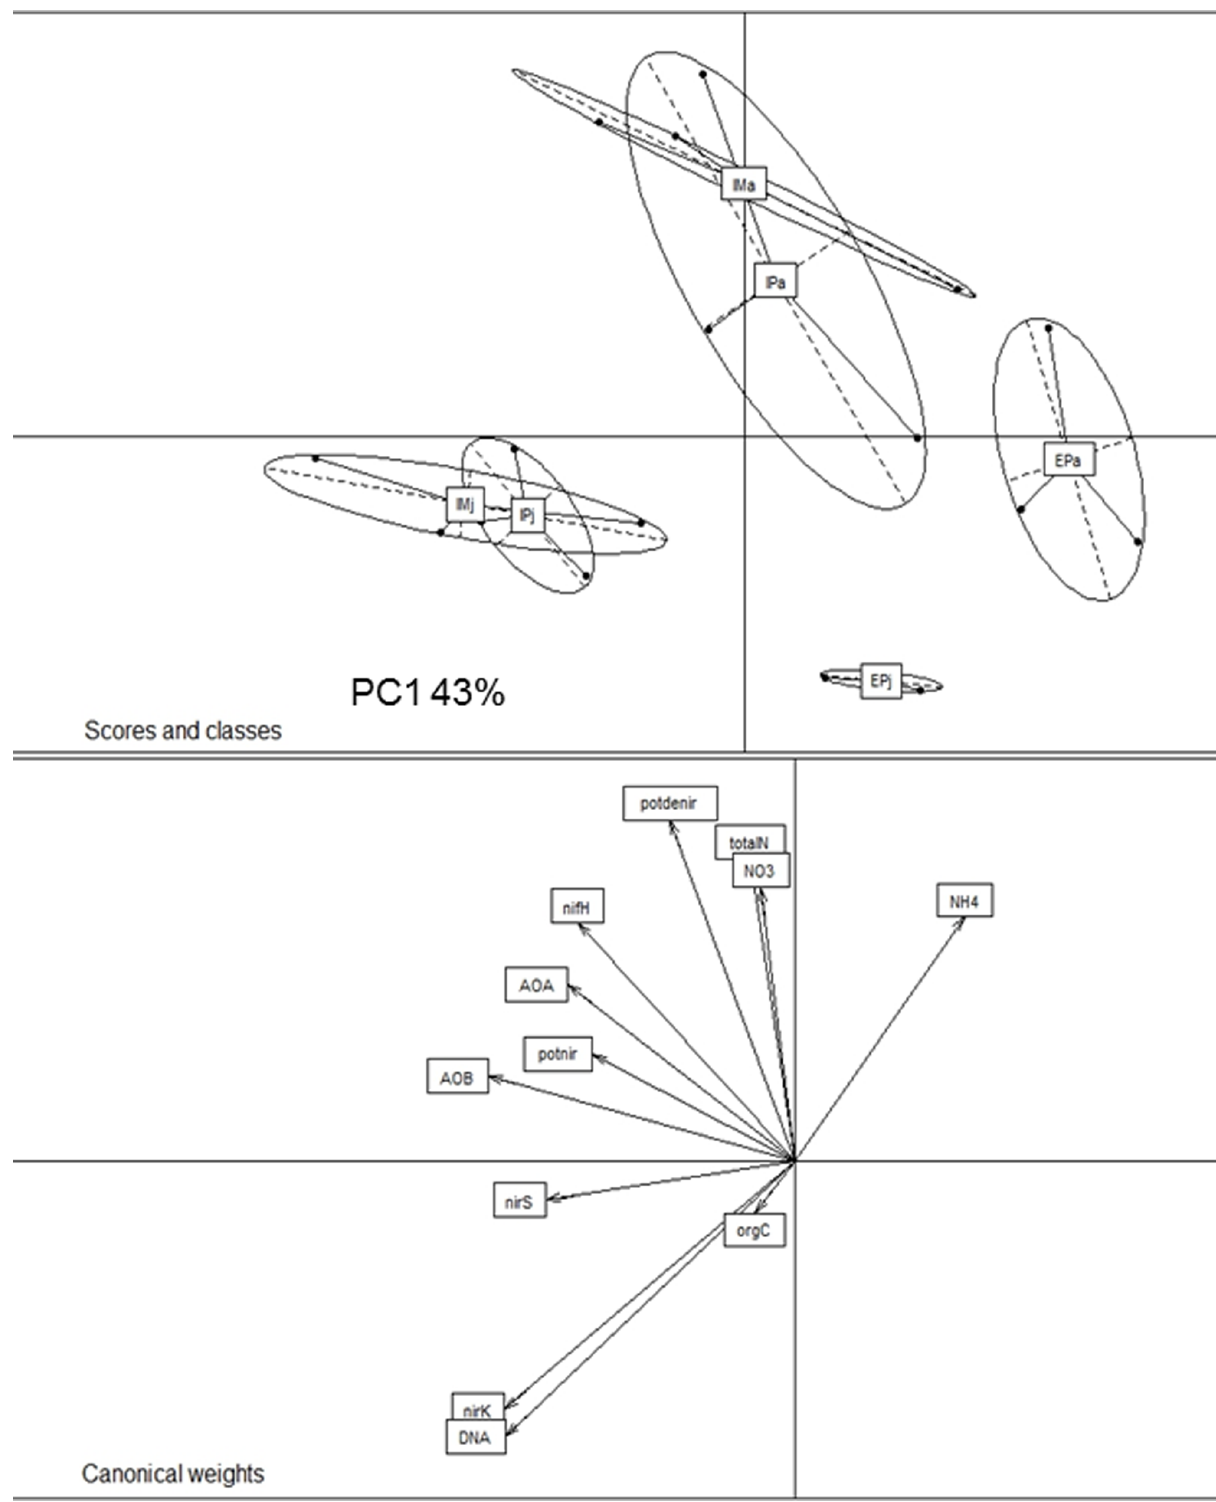
Figure 3. Between group analysis (BGA) using the mean values of all five replicates from each site. For calculation all data were logarithm-transformed, scaled and calculated using the R software package (www. r-project.org). The small letters a and j sign the April and July samples. Clear differentiation according to the sampling time point is visible (all April samples are on the right site in the upper part, all July on the left site in the lower part). Also the intensely used sites are clear separated from the extensively used plots whereas the separation is more clear in July.